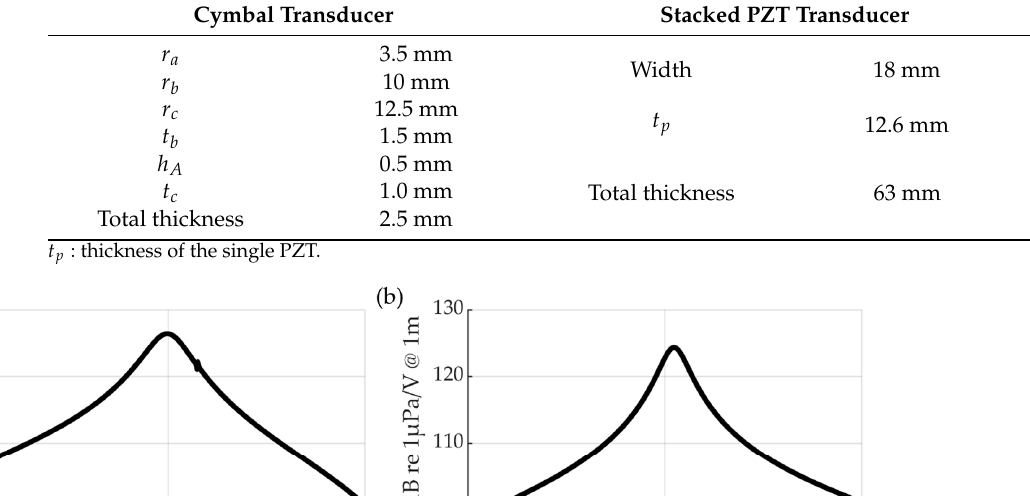
Table 2. Parameters of cymbal transducer and stacked PZT transducer.